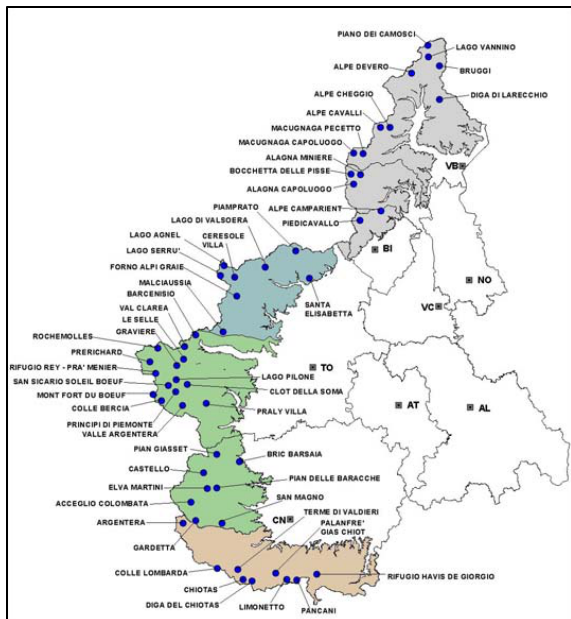
Fig. 1. The snow depth manual stations (blue dots) considered in Figure 1. The snow depth manual stations (blue dots) considered in this study. In colours the Alpine this study. In colours the Alpine sectors (grey: Northern sector, light sectors (grey: Northern sector, light blue: North-western sector, green: Western sector, pink: South- blue: North-western sector, green: Western sector, pink: South- western sector). As shown in the Fig.2, the gap of the mean daily new snow accumulation with respect to the climatology started from November, increased in December significatively and persisted throughout